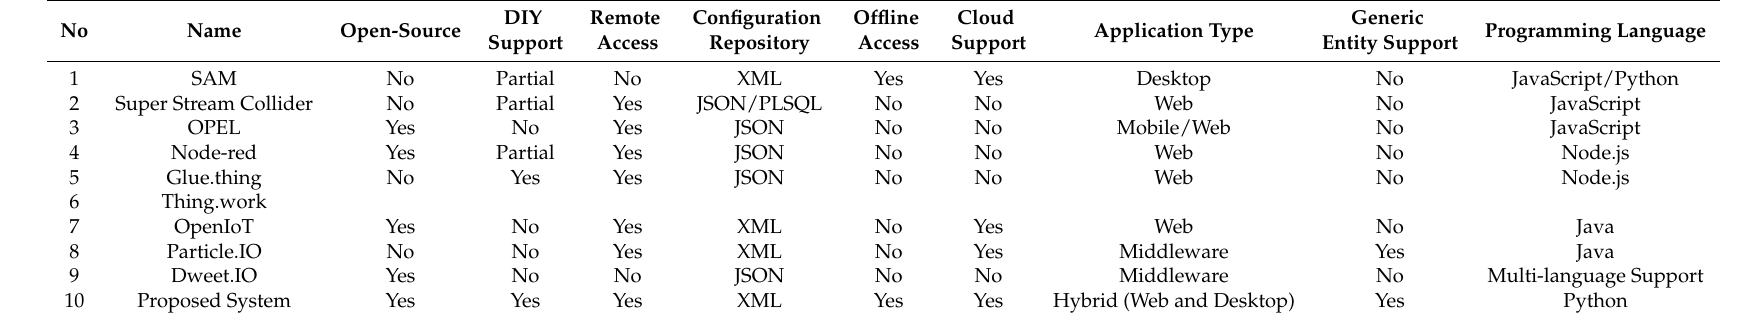
Table 5. Comparative analysis of the proposed system with the related